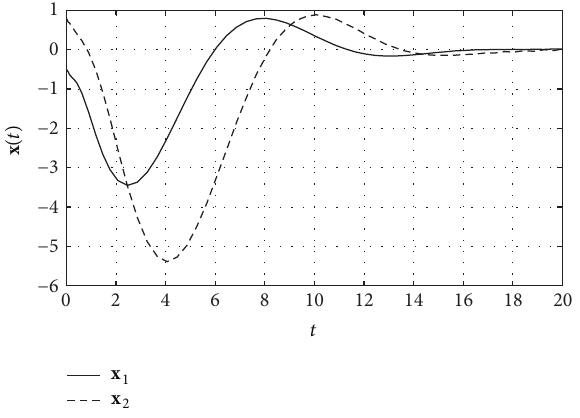
Figure 2: The trajectories of closed-loop controlled system state x (𝑡) .